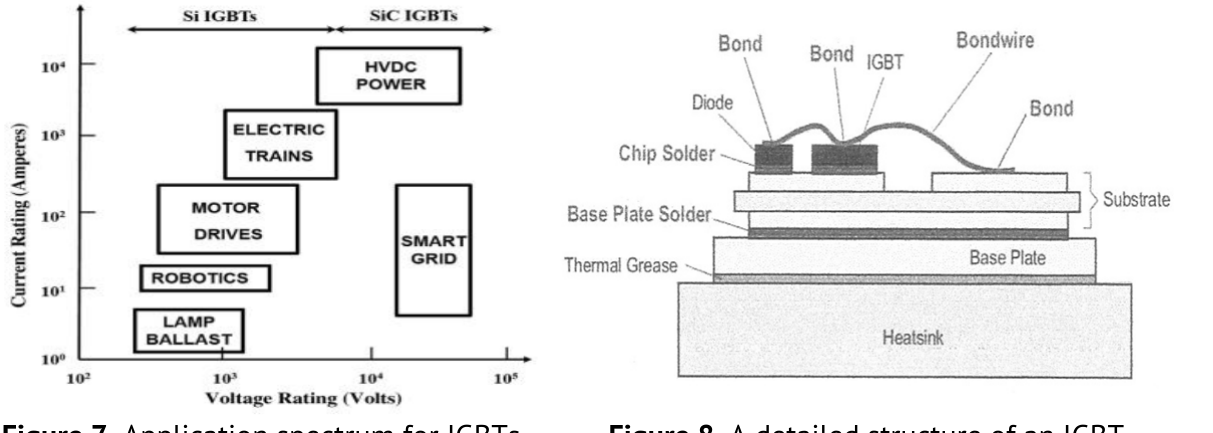
Figure 7. Application spectrum for IGBTs (after [9]).